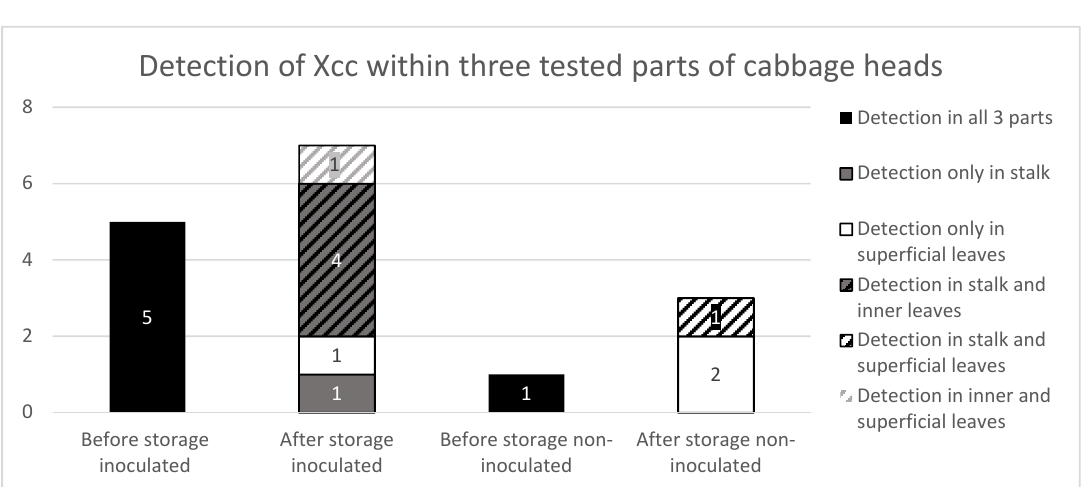
Figure 1. Detection of Xcc within three parts of inoculated and non-inoculated cabbage heads at harvest and after storage.